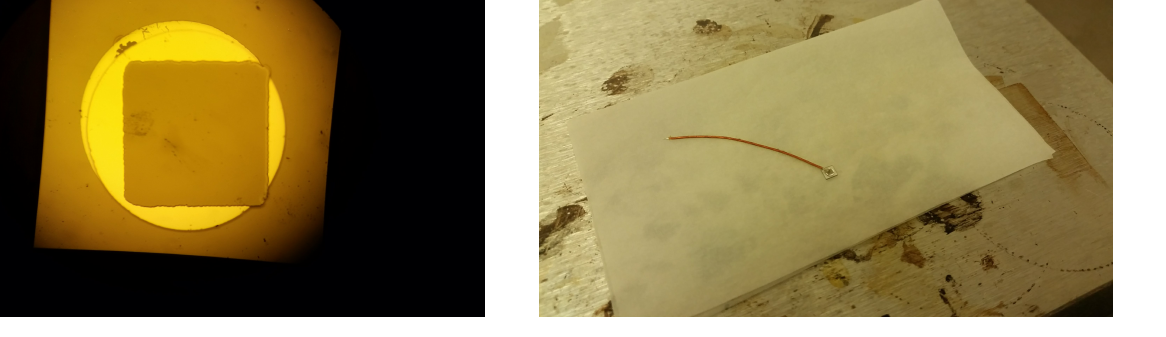
Figure 7. The electrode and the conversion layer at diamond crystal - first side (first detector)